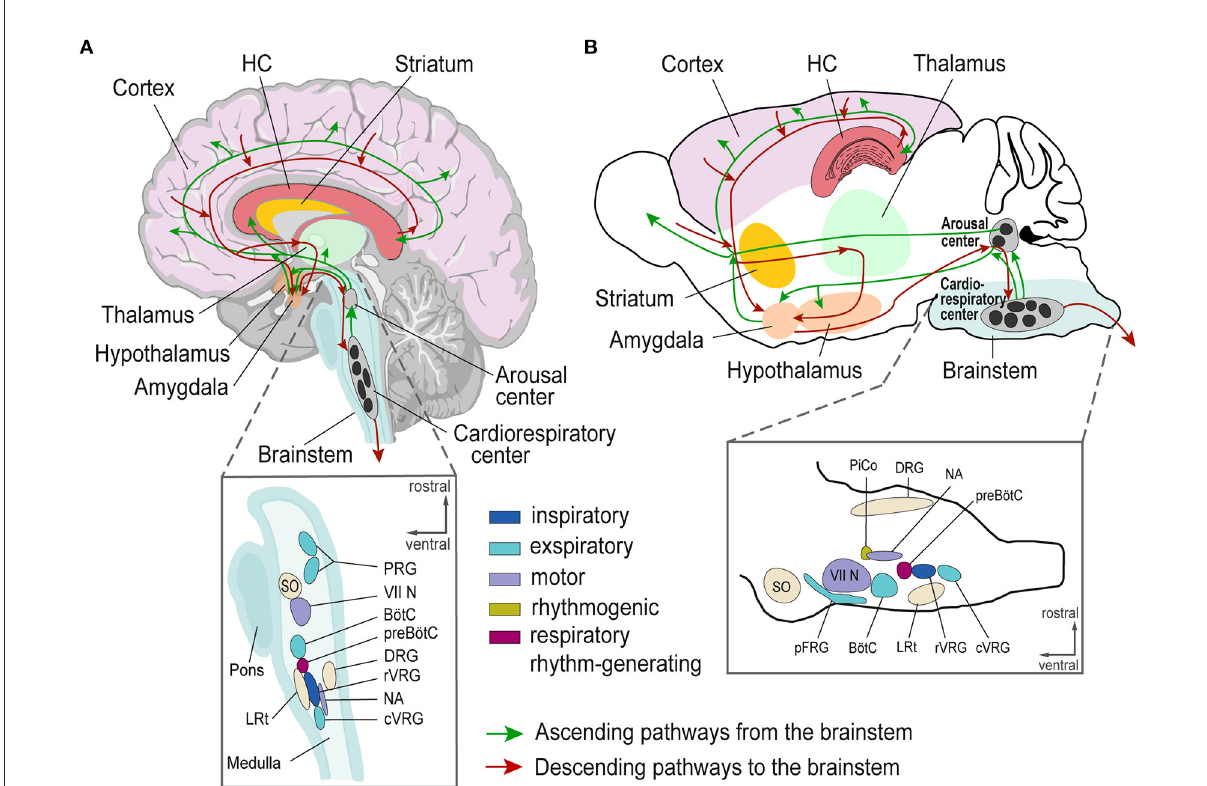
FIGURE2 Schematic of brain regions involved in epileptic activity and cardiorespiratory regulation in humans (A) and mice (B). (A, B) Top, Human and mouse brain with depicted Cortex (pink), Hippocampus (red), Striatum (yellow), Thalamus (green), Hypothalamus (orange), and brainstem (blue) with ascending (green lines) and descending (red lines) projections. Bottom, Magnification of brainstem nuclei. VII N, facial nucleus; BötC, Bötzinger Complex; cVRG, caudal ventral respiratory group; DRG, Dorsal respiratory group; HC, Hippocampus; LRt, lateral reticular nucleus;